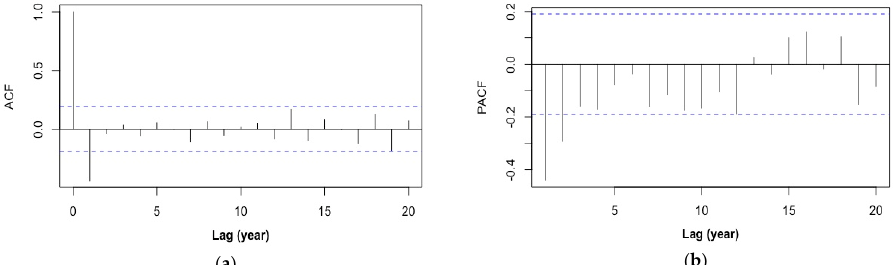
Figure 2. ( a ) The autocorrelation function (ACF) and ( b ) partial autocorrelation function (PACF) of the first-order difference of the Colorado River WS time series. The two blue dashed lines on each plot denote the corresponding 95% confidence interval.